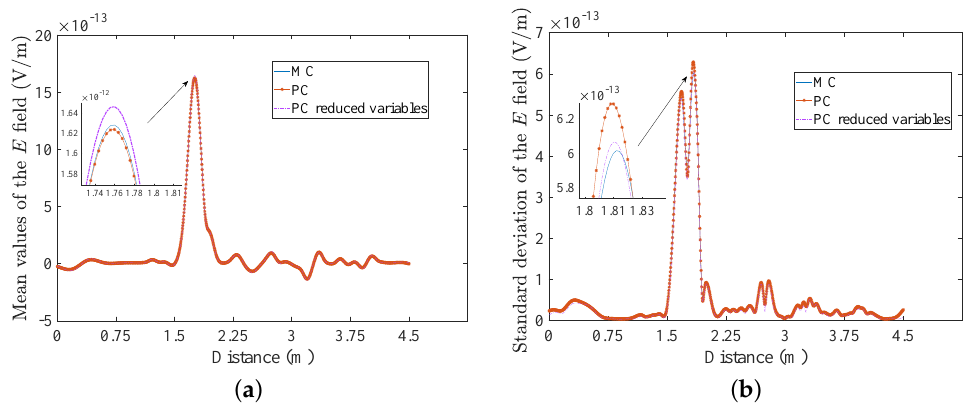
Figure 2. ( a ) Mean value and ( b ) standard deviation of the electric field for the first case of the 1D transmission-line problem. PC, Polynomial Chaos.